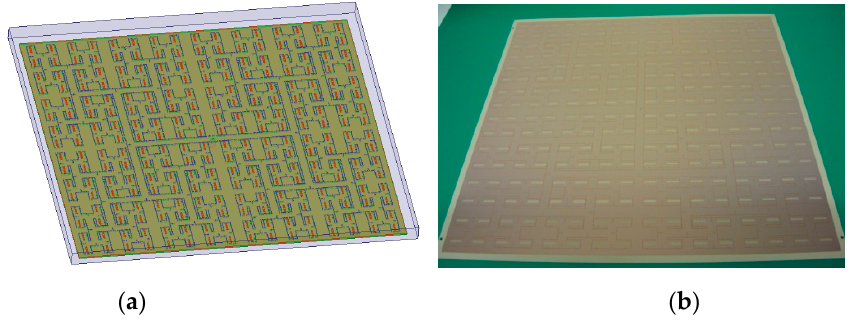
Figure 18. SIW array prototype: ( a ) Sketch of the prototype; ( b ) Photograph of the prototype.